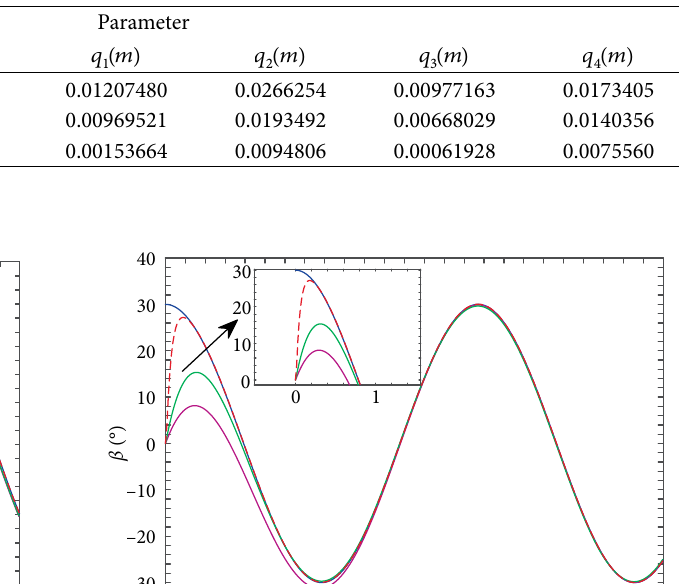
Table 4: The comparisons of root square mean error with different controllers.